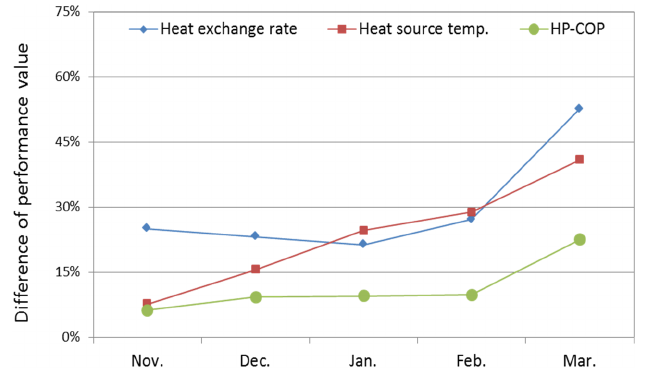
Figure 9. Simulation result of energy rate and solar radiation.